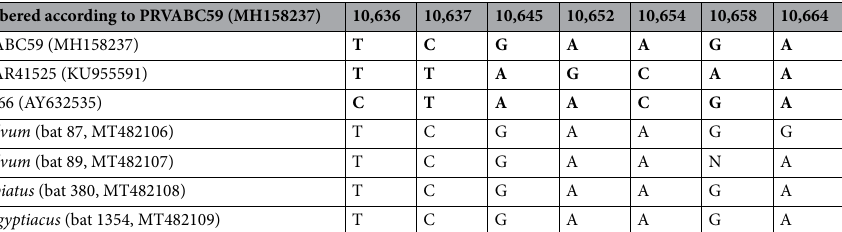
Table 3. Nucleotides present at various positions in 3 ′ UTR indicating that sequences derived from four wild-caught bats align most closely to the Asian strain of ZIKV. The significance of the bold was to indicate that the nucleotides were associated with reference sequence/accessions pulled from GenBank we used for our multiple alignment. Position are numbered based on PRVABC59 (MH158237). For each sample, bat species, identification number, and Genbank accession number are provided.